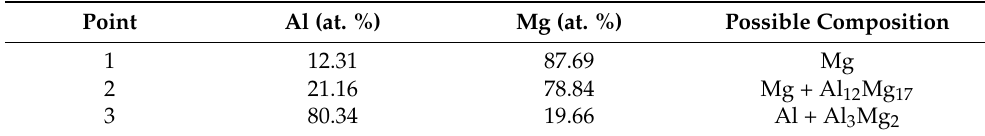
Table 2. EDS results in the location marked in Figure 5.